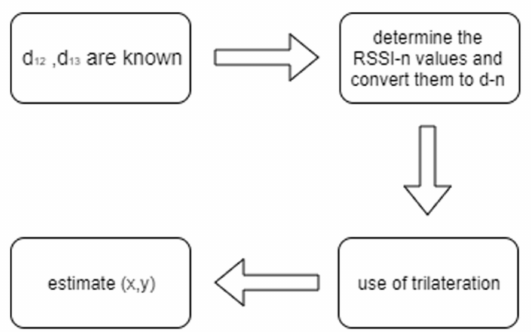
Figure 6. Algorithm for the calculation of coordinates.